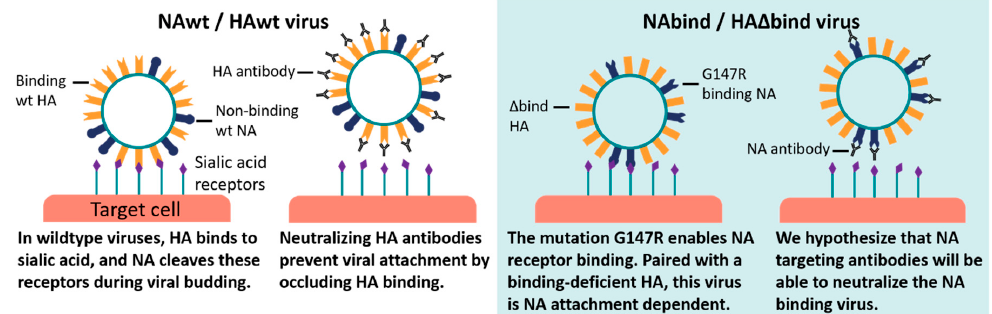
Figure 1. Proposed mechanism of neutralization of neuraminidase (NA)-binding-dependent viruses by anti-NA antibodies. Most influenza viruses use hemagglutinin (HA) to bind and enter cells (left panel), so antibodies targeting HA can prevent infection while NA antibodies only inhibit the release of new virions. But in our engineered NA-binding-dependent virus (right panel), antibodies against NA can inhibit infection.